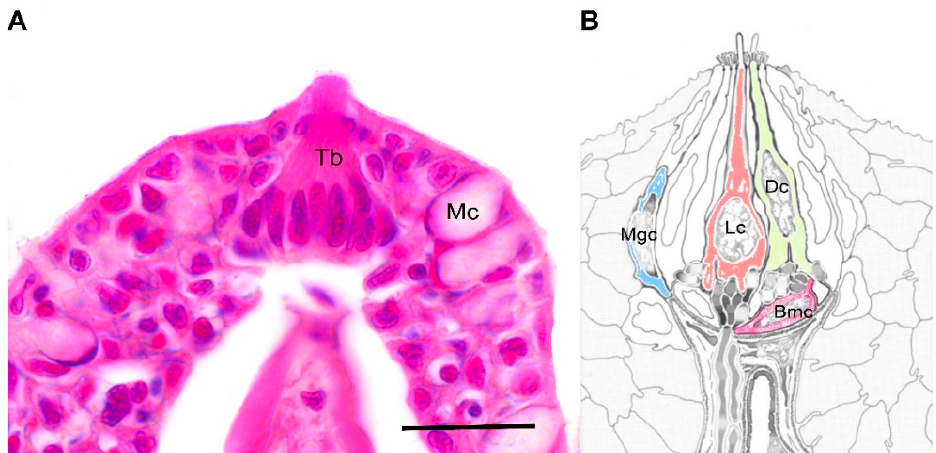
Figure 1. Taste bud. ( A ) Histological section of a single taste bud protruding from the pluristratified epithelium of the oropharyngeal cavity. Hematoxilin-eosin staining; ( B ) Schematic representation of the ultrastructural organization of fish taste buds (modified from Hansen et al. 2002). Abbreviations: Tb = taste bud; Mc = mucous cell; Dc = dark cell (green); Lc = light cell (red); Bmc = basal cell (pink); Mgc = marginal cell (blue). Scale bar = 20 µm.